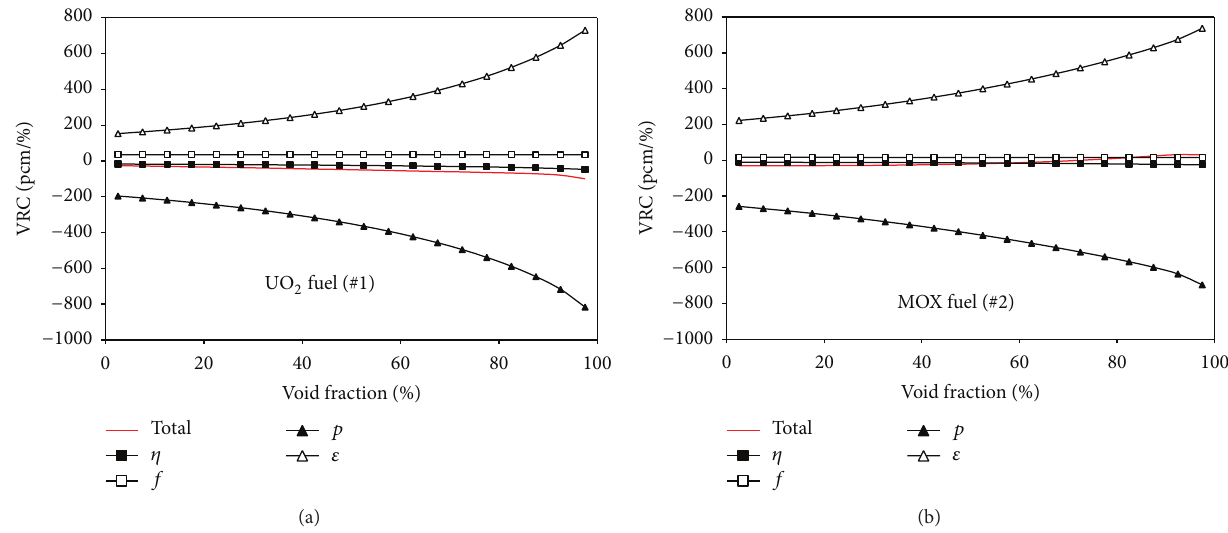
Figure 5: Decomposition of four factors formula in case of UO 2 and MOX fuels.